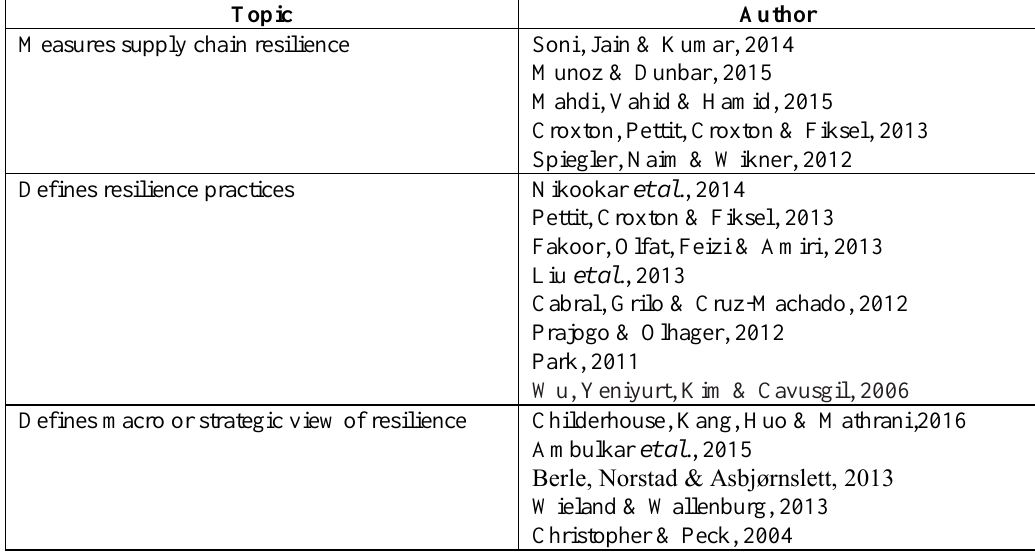
Table 2. Empirical Evidence of Supply Chain Resilience